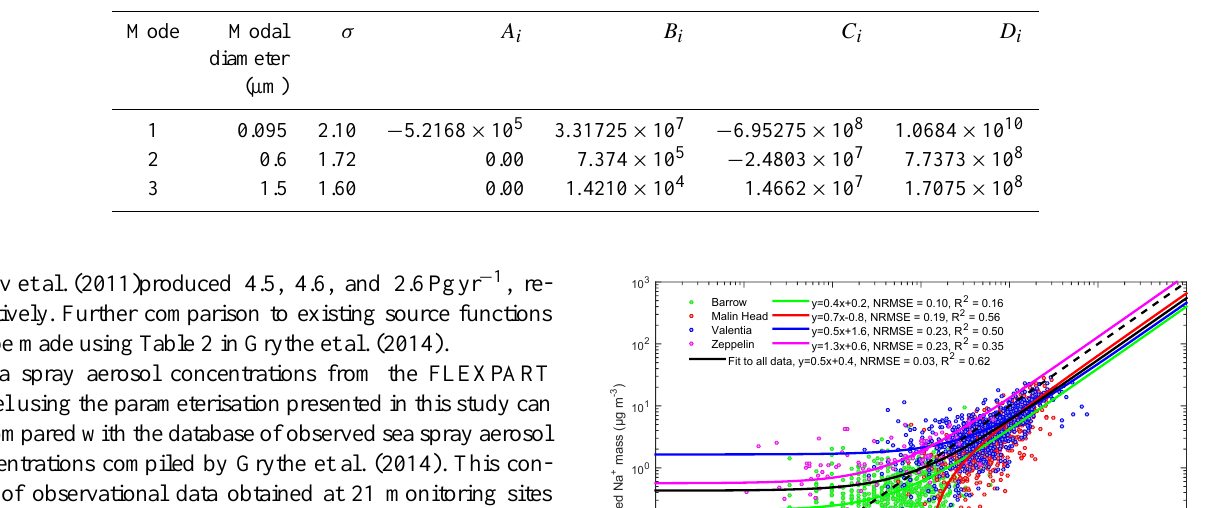
Table 2. Modal diameters, geometric standard deviations ( σ ), and the polynomial coefficients for the number flux ( N i ) of each of the three log-normal modes in the here derived parameterisation (Eq. 9).